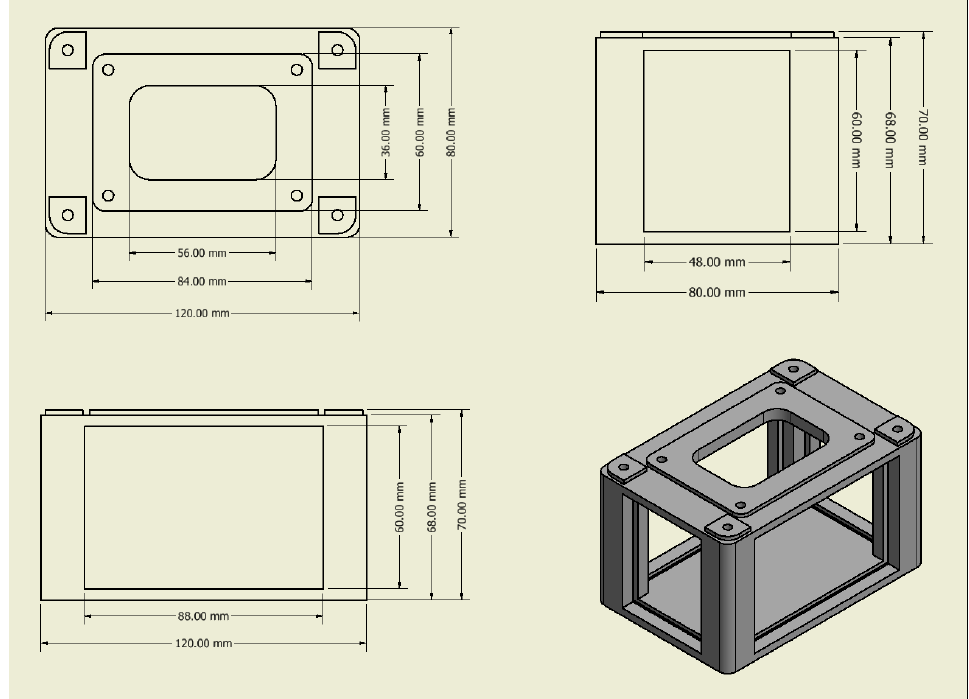
Figure 3. Technical sheet of the case. Only significant dimensions are shown.